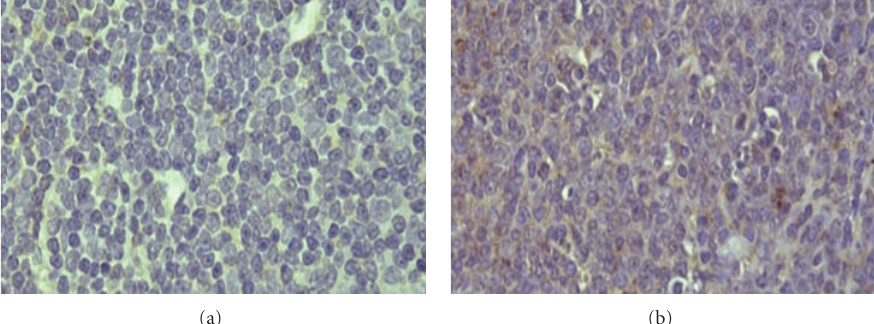
Figure 7: V 2 O 5 e ff ects on the lymphocyte proliferation index. In control spleen, a basal proliferation index is observed. (a) After vanadium exposure, the number of lymphocytes in division increased contrasting with control (b)